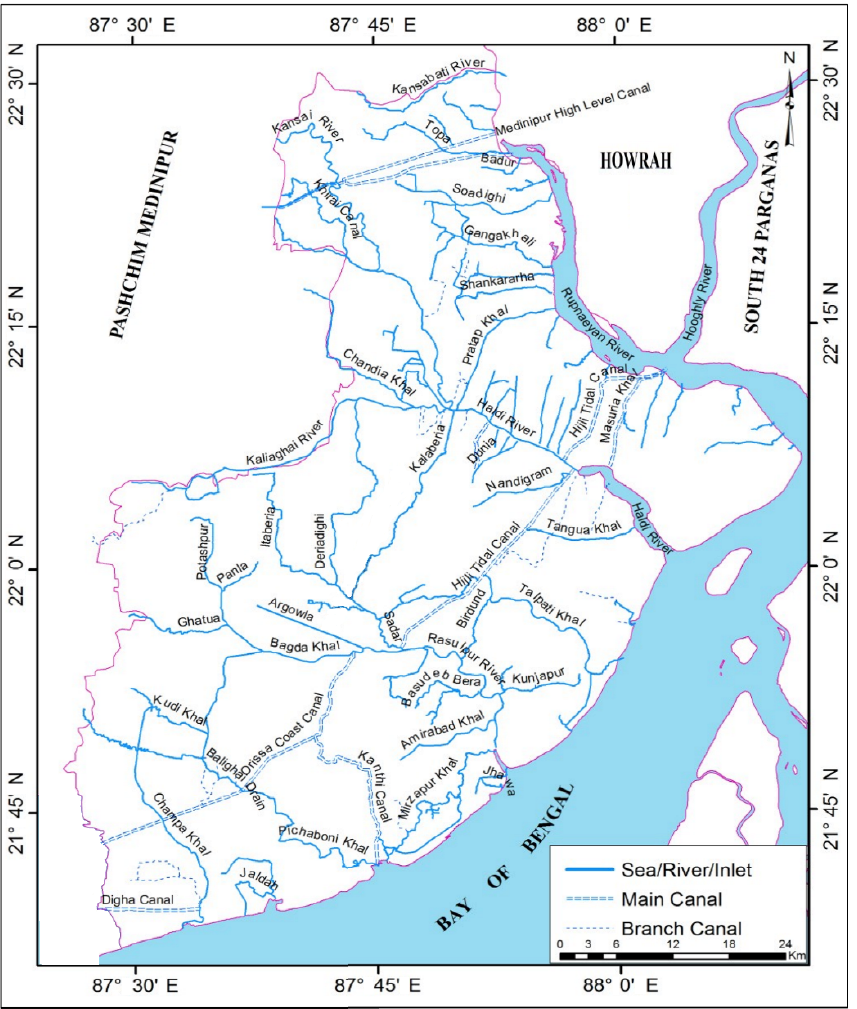
Figure 3. River map of Purba Medinipur district. Source: District Environment Plan (Purba Me- dinipur)